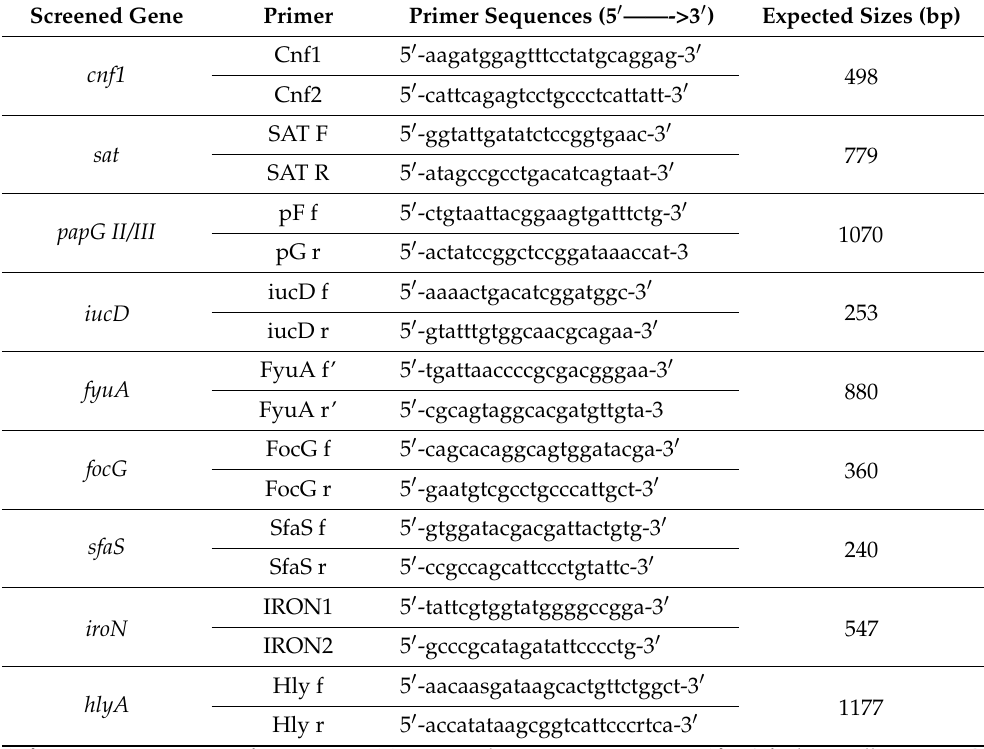
Table 1. Sequences of the primers used for target